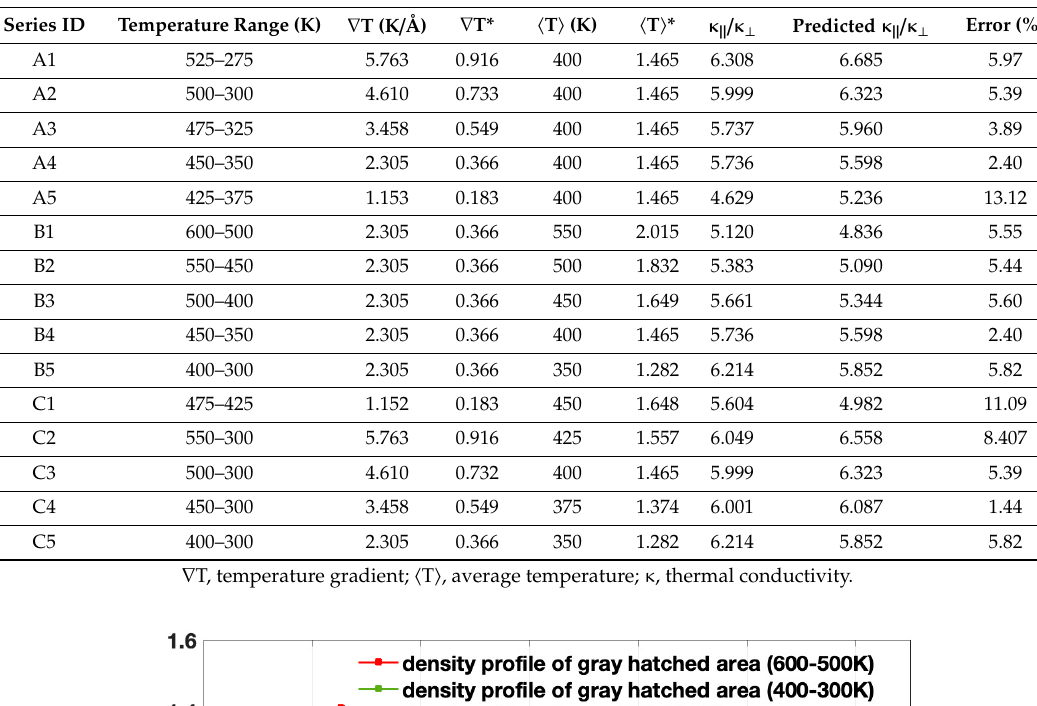
Table 1. Results for water with “hydrophobic” hot and cold copper walls maintained at the temperatures shown. Errors reported were estimated by changing the initial conditions.